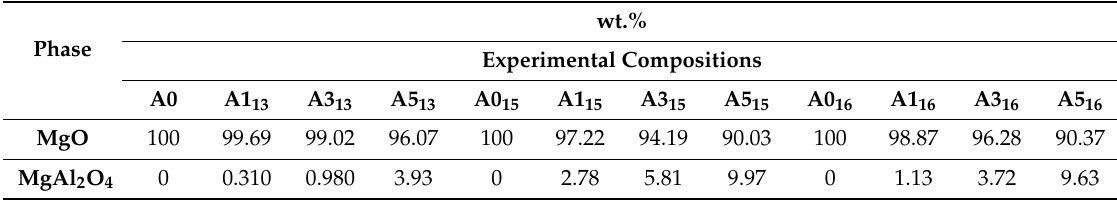
Table 4. Quantitative phase estimation of crystalline phases by the relative intensity method. Phase